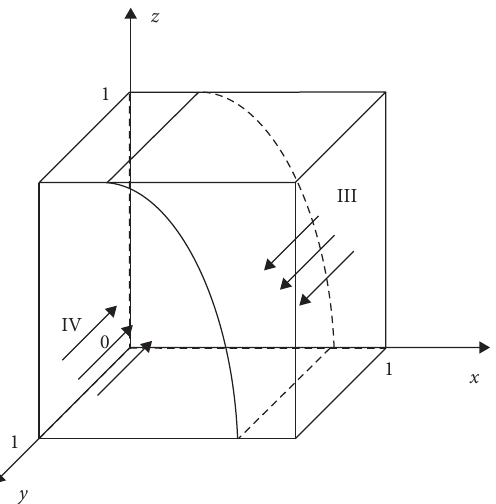
Figure 2: The enterprises’ dynamic